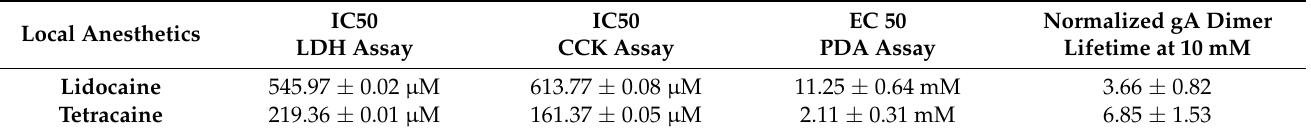
Table 1. Summaries of the LAs concentration employed in IC50 and EC50 analysis, and normalized gA dimer lifetime measurement at 10 mM of